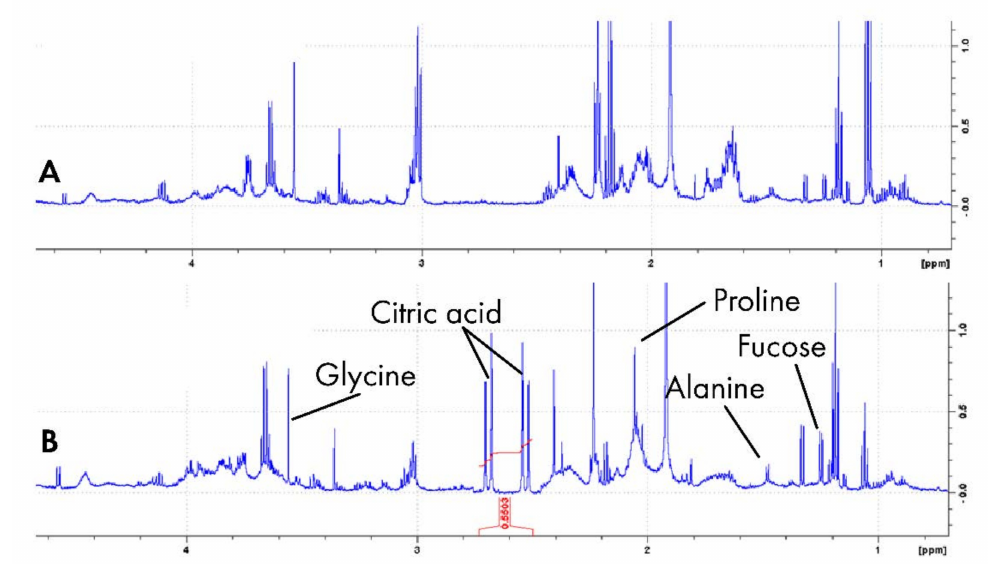
Figure 2. Spectral characteristics of human saliva ( A ) stimulated with paraffin (masticatory stimula- tion) and ( B ) by citric acid (gustatory stimulation). Citric acid added prominent peaks at around 2.50 and 2.70, which occur in a relatively unoccupied region of the spectrum